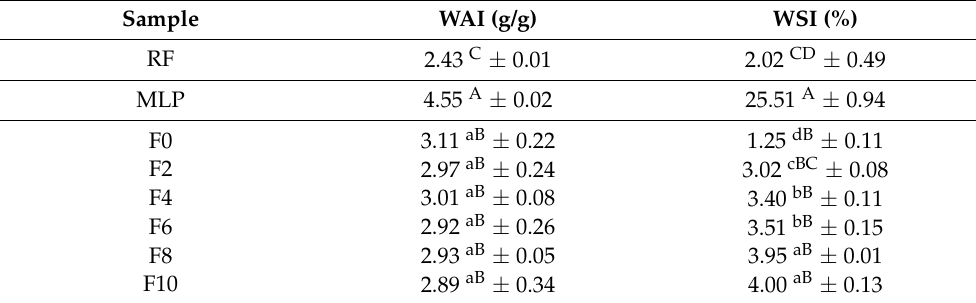
Table 3. Water absorption and water solubility indices of raw ingredients, F0, and FRNs.